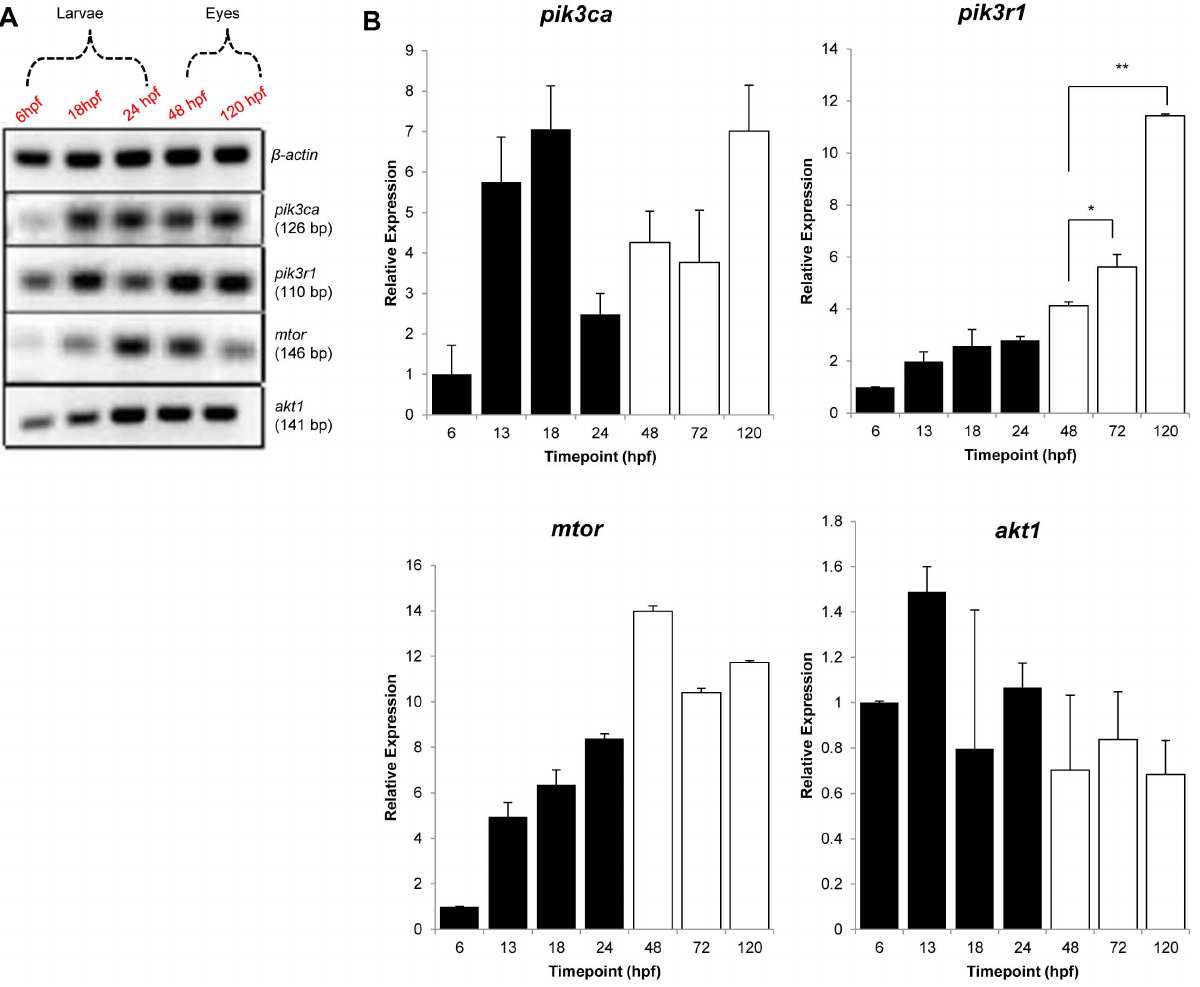
Figure 1. PI3K/Akt/mTOR gene expression in developing Tg(fli1:EGFP) zebrafish. (A) RT-PCR and (B) qPCR examined the mRNA levels of zebrafish pik3ca, pik3r1, mTOR and akt1 genes. Embryos were harvested at 6, 13, 18 or 24 hours post fertilization (hpf) and eyes at 48, 72 or 120 hours post fertilization (hpf). (A). Relative expression, normalised to 18S rRNA , of pik3ca, pik3r1, mTOR and akt1 mRNA levels in developing zebrafish embryos (black columns) and eyes (white columns) expressed relative to the 6 hpf stage. Results are expressed as mean 6 S.D. ( n =3), *P , 0.05, **P , 0.01.